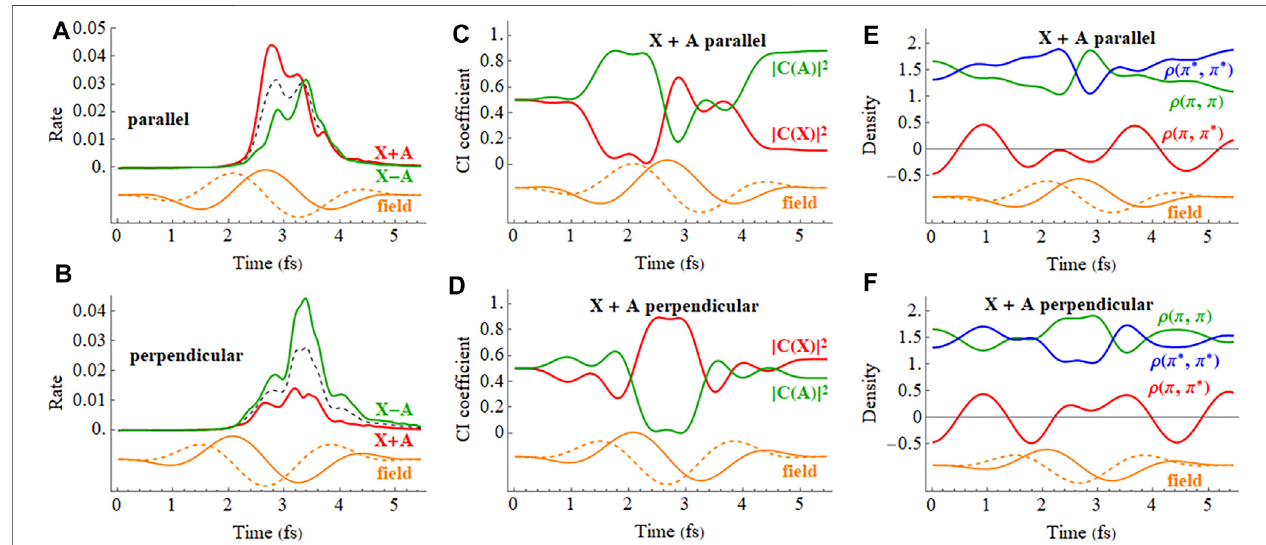
FIGURE13|(A,B) IonizationrateforX+AandX − Acoherent superpositions fora2cycle,800 nmcircularlypolarized pulsewith E max =0.0566auwiththecarrier envelope maximum parallel and perpendicular to the molecular axis (incoherent average of X and A in black dashed). (C,D) CI coef fi cients for the X and A con fi gurations (red and green, resp.) in the normalized wavefunction for X + A with the carrier envelope maximum parallel and perpendicular to the molecular axis. (E,F) Density matrix elements for the π x and π p x orbitals for X + A (the orange traces are proportional to the electric fi eld). A movie of the hole density is available in Supplementary Figure S3 of the Supporting